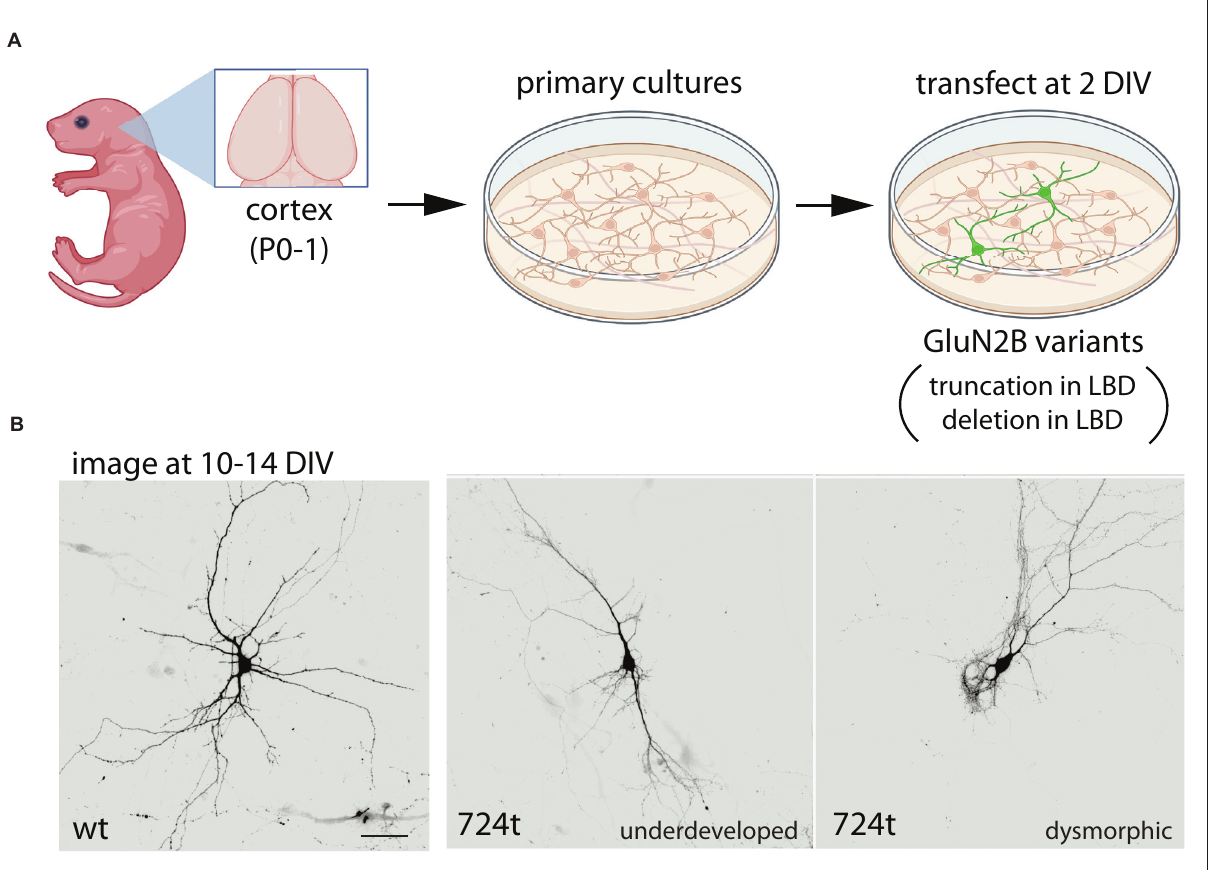
FIGURE3 Expression of GluN2B variants interferes with dendrite morphogenesis. (A) Primary neuronal cultures were prepared from wild-type rat cortex, at postnatal day 0–1 (P0–1), then transfected at 2 days in vitro (DIV) with either wild-type GluN2B or GluN2B bearing a truncation at amino acid 724 (724t), within the LBD (Sceniak et al., 2019; Bahry et al., 2021). In parallel, GluN2B with a large depletion in the LBD was also examined, producing similar results. (B) In contrast to neurons expressing only wild-type GluN2B, neurons expressing mutant GluN2B had impaired